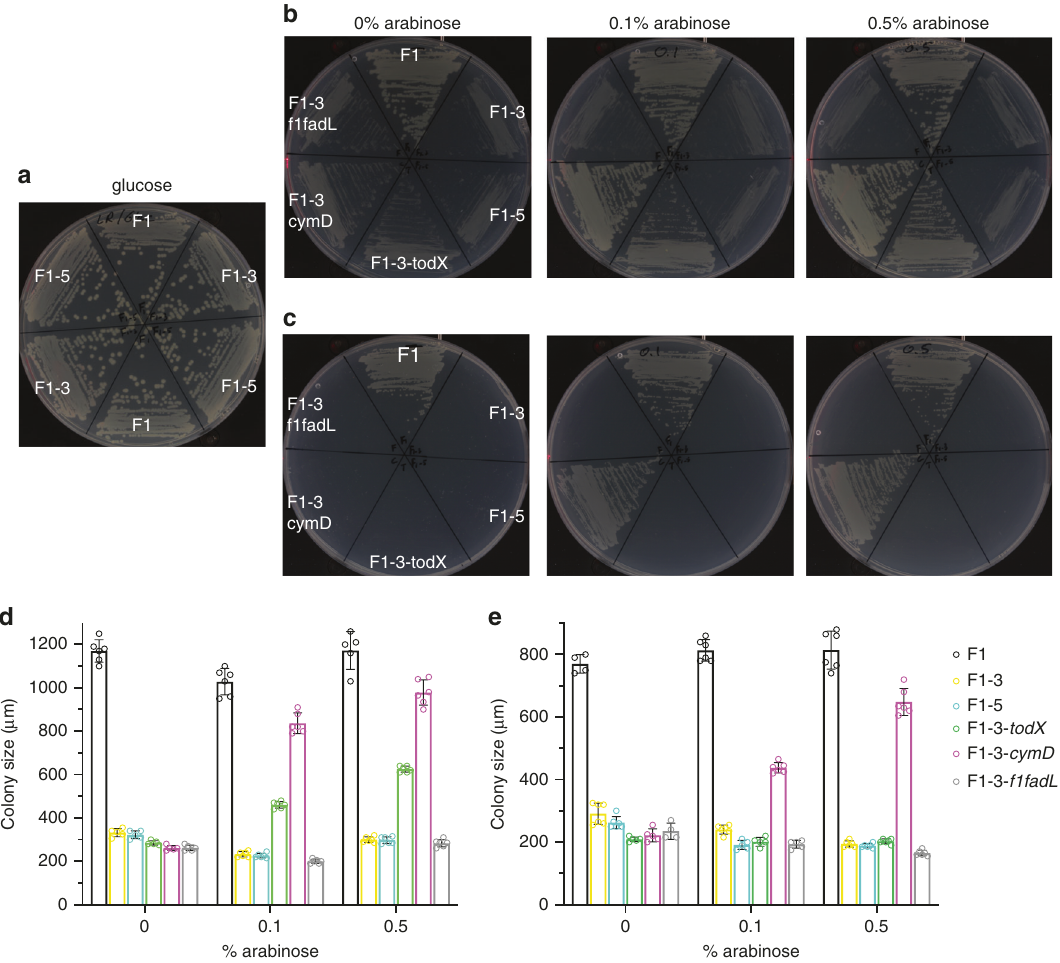
Fig. 1 TodX and CymD are MAH uptake channels. a Growth of Pp F1, Pp F1-3 and Pp F1-5 on 0.5% glucose. b , c Growth of various Pp F1 strains with and without Tn7 complementation on minimal medium with vapour-phase toluene ( b ) or p-cymene ( c ) as the sole carbon source. Growths shown are representative of 2 or 3 plates. d , e Individual maximum colony sizes from two independent plates after ( d ) 4 days growth on toluene at 20 °C or ( e ) 5 days on p-cymene at 30 °C with different arabinose concentrations. Reported values are mean ± s.d ( n = 5 – 8). Bar graphs and dot plots were generated in GraphPad Prism version 7. Source data for colony sizes are provided in the Source Data fi